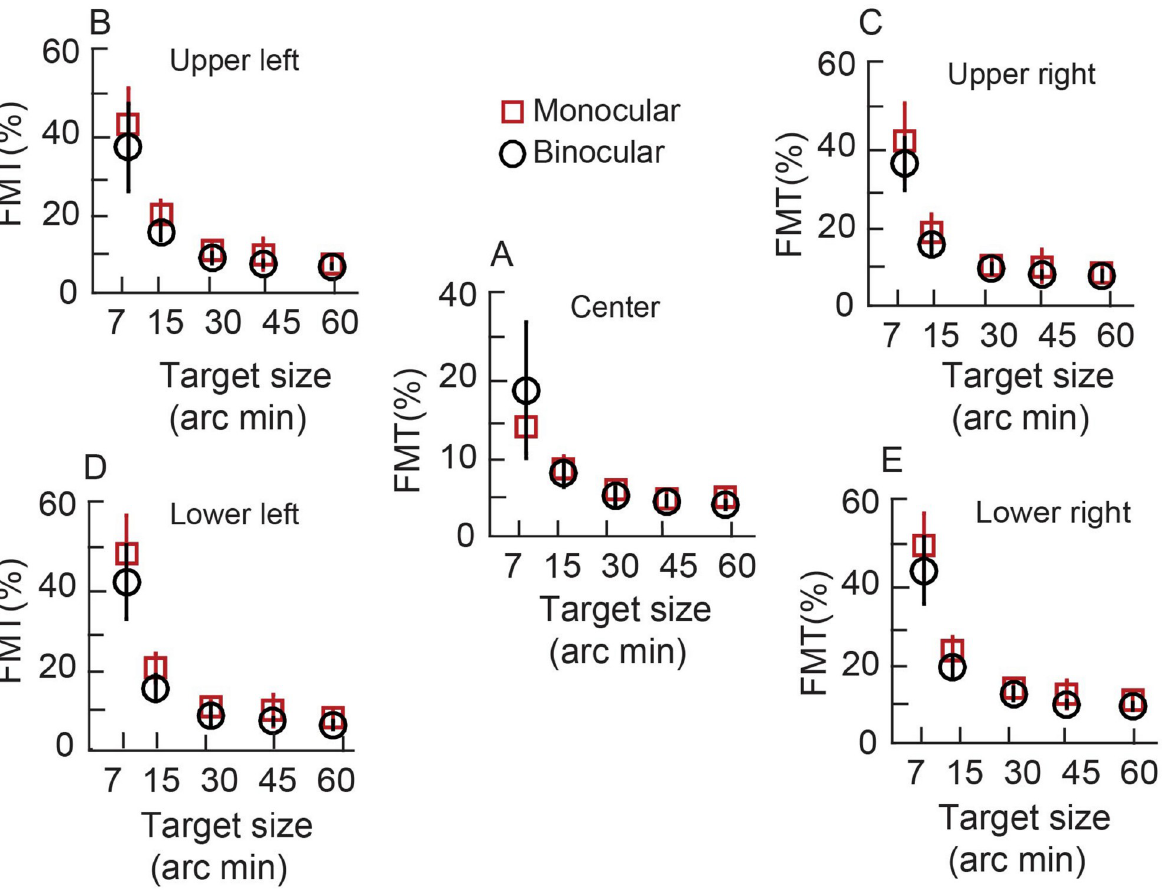
Fig 4. Mean ( ± 1SD) better of the two eyes’ monocular FMTs and binocular flicker thresholds across 13 subjects plotted for mesopic condition as a function of target size. All other details are same as Fig 3.